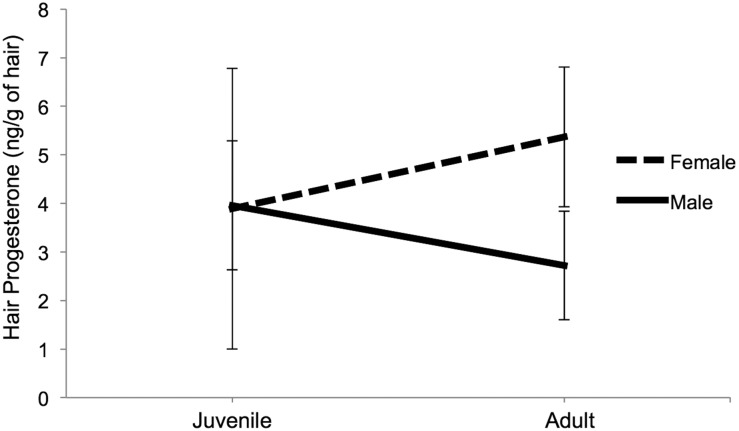
Interaction plot representing differential mean progesterone concentration (in nanograms per gram of hair) according to age class in Canada lynx. Error bars represent ±SD.